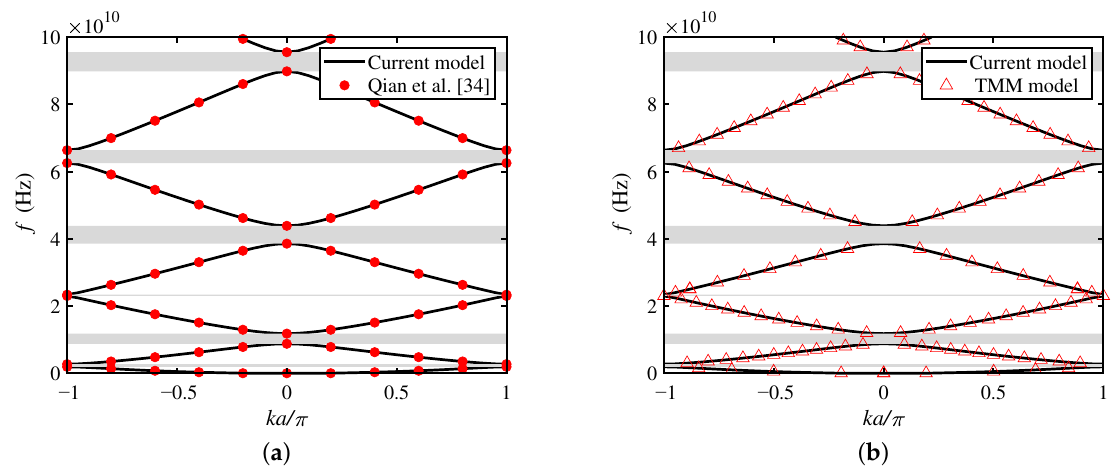
Figure 2. Comparison of bandgaps of the current model without microstructure and piezomagnetic effects with ( a ) Qian et al. [34], and ( b ) TMM model.